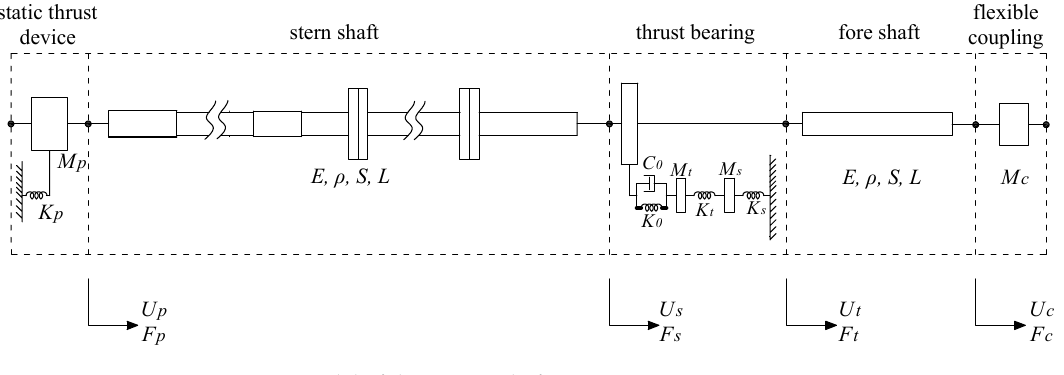
Figure 7. Model of the test rig